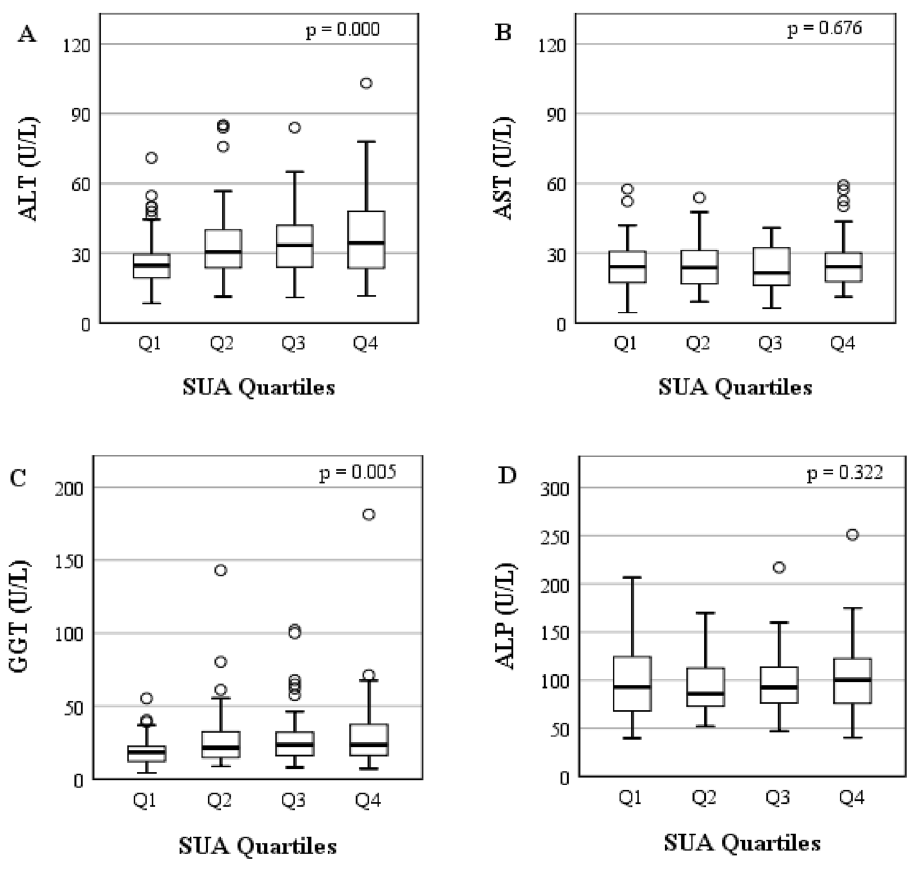
Figure 2. Levels of liver enzymes across the SUA quartiles.